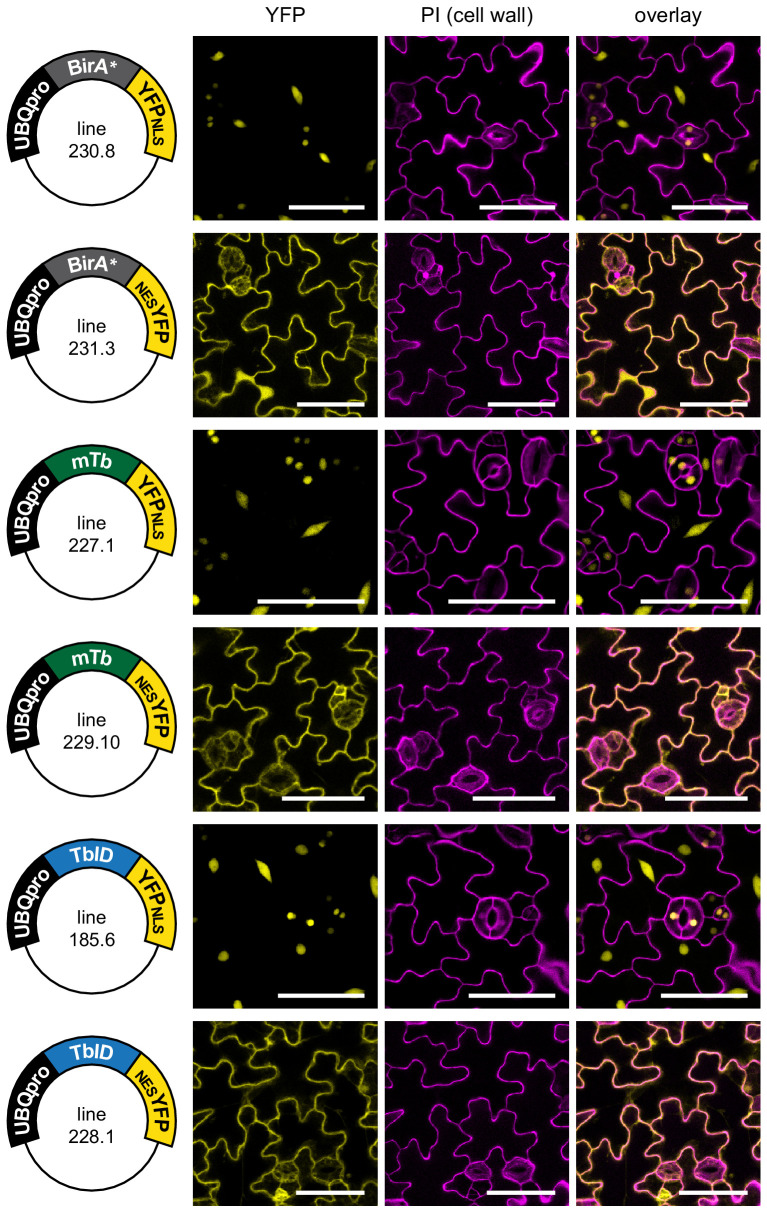
Subcellular localization of biotin ligase constructs in stable Arabidopsis lines.Confocal microscopy images of the cotyledon epidermis of 5-day-old Arabidopsis seedlings transformed with UBQ10pro::BirA-YFPNLS or UBQ10pro::BirA-NESYFP expression vectors (BirA = BirA*, mTb or TbID). Shown are the YFP channel (yellow), the cell walls stained with propidium iodide (purple) and an overlay. Scale bar = 50 µm. Constructs and lines used for images are indicated on the left. Nuclear targeted BirA-YFP (NLS) constructs were mostly nuclear, and cytosol targeted (NES) constructs were excluded from the nucleus.